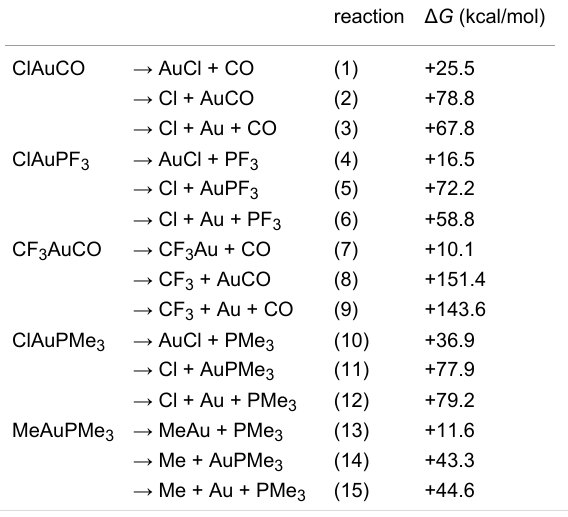
Table 2: Calculated reaction energies for isolated Au(I) complexes. The values of Δ G are calculated for a temperature of 298 K and a pressure of 1 × 10 − 4 Pa.